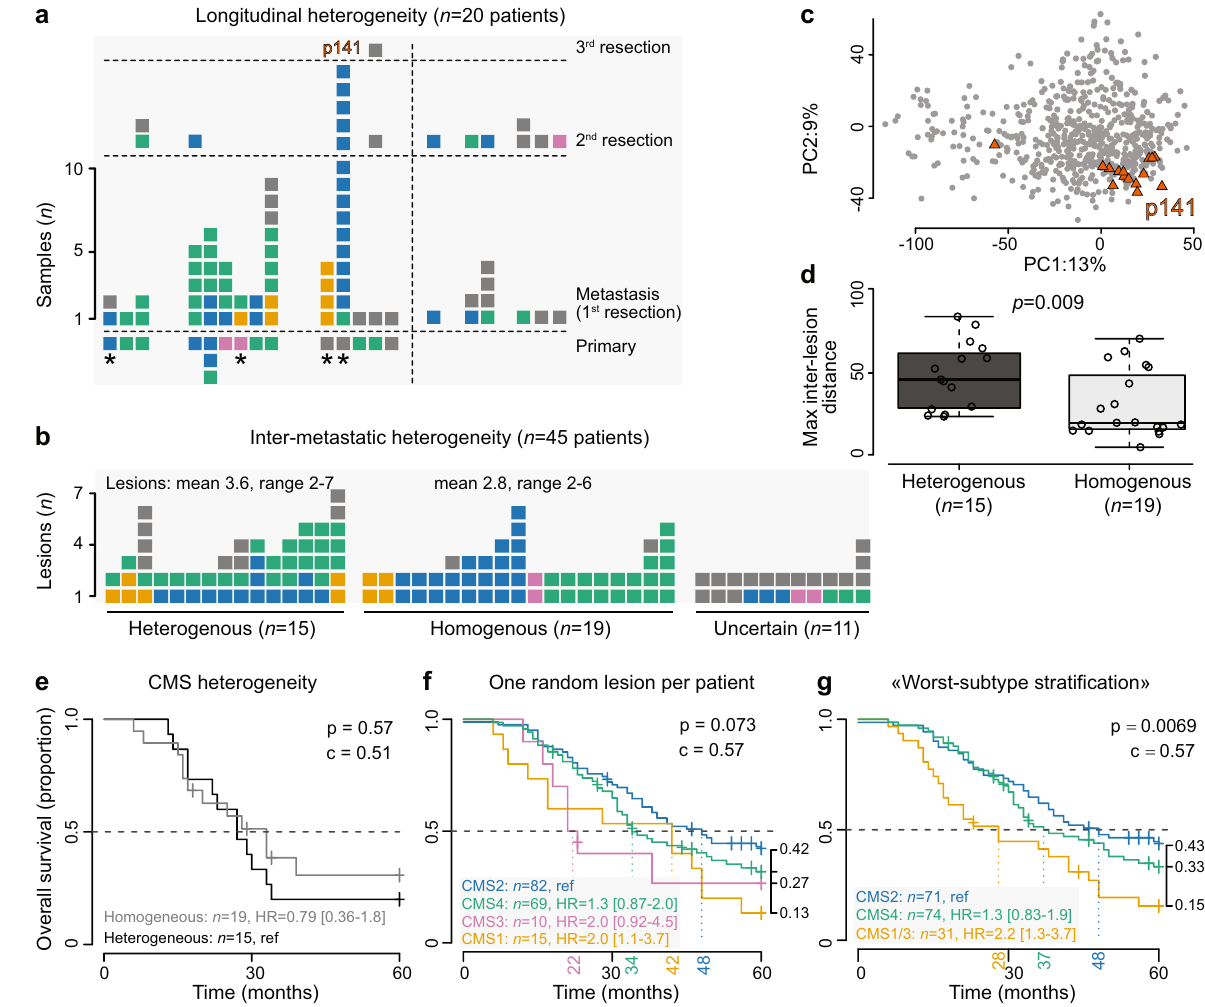
Fig. 3 Pronounced CMS heterogeneity in metastatic CRC. Stacked barplots show intra-patient heterogeneity (each bar represents one patient and each square represents one tumor sample) of CMS assignments for patients with a matched primary tumors (classi fi ed with the original classi fi er)/longitudinal samples and liver metastases (classi fi ed with the new, tailored classi fi er; asterisk indicates patients with no neoadjuvant treatment), and b multiple resected metastatic lesions. c PCA plot illustrating transcriptomic heterogeneity for one patient with heterogeneous CMS classi fi cations (p141), where most lesions are relatively similar and classi fi ed in the same CMS group, but with a single strong outlier sample with a different classi fi cation. d Boxplots (center line, median; box limits, upper and lower quartiles; whiskers, 1.5 × interquartile range) where patients with heterogeneous and homogeneous CMS classi fi cations are compared with respect to maximum inter- lesion distance, calculated as Euclidean distances in the three-dimensional PC1 – PC3 space. Kaplan – Meier survival estimates for patients with resected liver metastases, strati fi ed by e inter-metastatic CMS heterogeneity, f CMS classi fi cation based on one randomly selected lesion per patient, and g “ worst-subtype strati fi cation ” according to the following rule: if any lesion CMS1/CMS3, then patient CMS1/CMS3; if no CMS1/ CMS3 and any lesion CMS4, then patient CMS4; if all CMS2, then patient CMS2. p -values were calculated by Wald tests, c is the concordance index, and HR is the hazard ratio. For survival analyses, each sample is assigned to the nearest (not necessarily con fi dent)